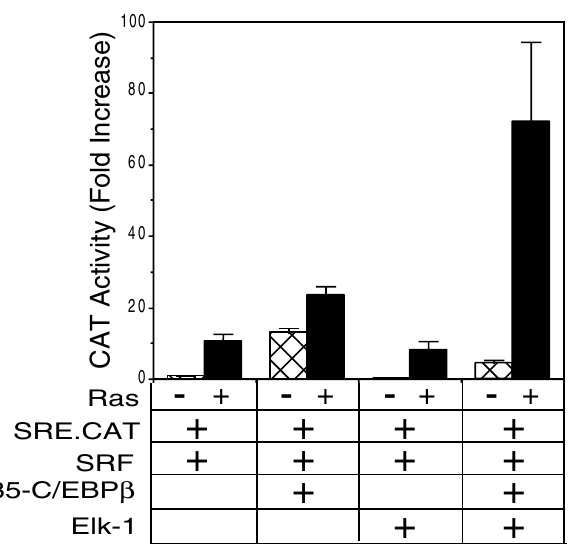
Figure 2 Elk-1 and p35-C/EBP β synergize in transactivation of the SRE. NIH 3T3 cells were transfected with 0.75 µ g of SRE.CAT and 0.75 µ g pCMV-SRF alone or with 0.75 µ g pCMV-LAP or 0.75 µ g pCMV-Elk1 in the absence or presence of 0.75 µ g pCMV- Ras.V12. Cells were serum deprived for 40 h prior to har- vesting. CAT activity was measured as previously described [33]. Data are the average of 4 determinations, and error bars represent standard